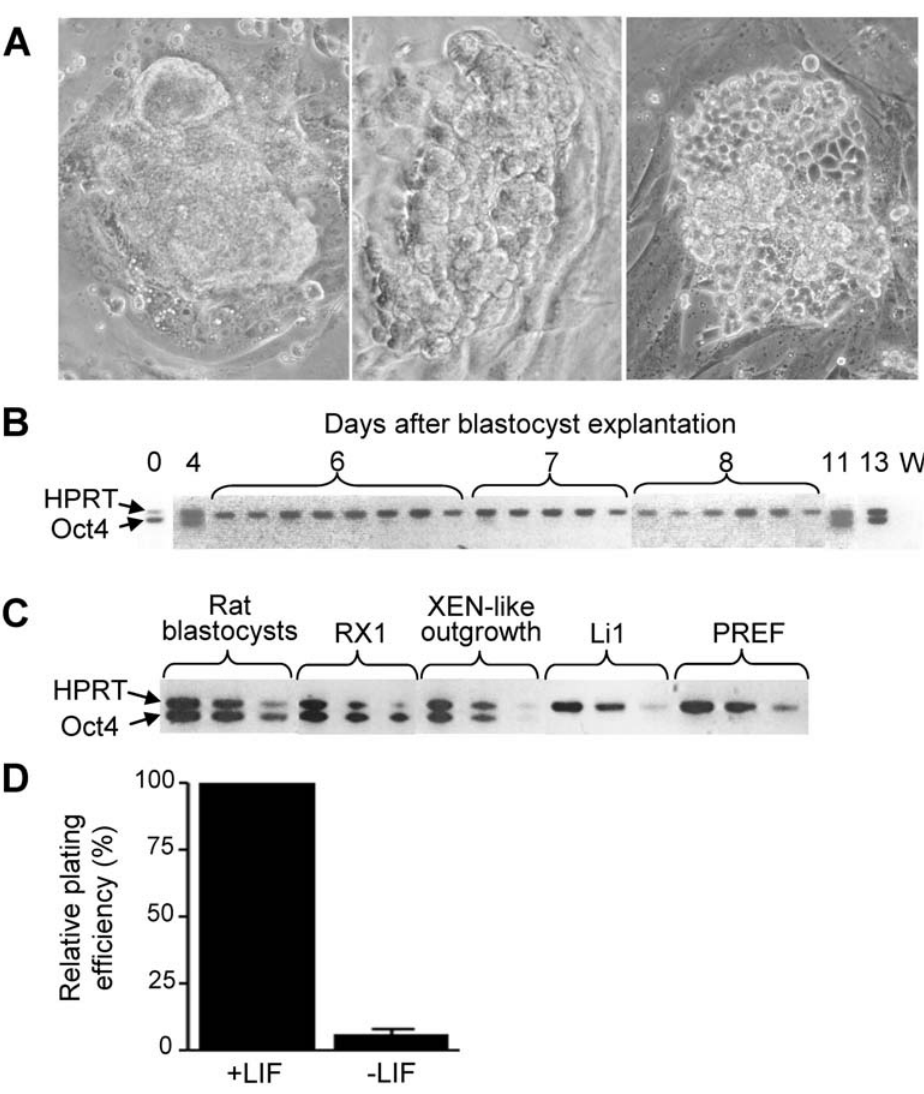
Figure 1. Properties of rat blastocyst outgrowths. ( A ) Phase contrast photographs showing stages of WKY rat blastocyst outgrowths kept on mitomycin-treated primary rat embryo fibroblasts (PREF). The outgrowths were initially smooth and compact (left), but converted to XEN morphology (right) , 10 days after blastocyst plating if not passaged, or a few days later if mechanically disaggregated into smaller clumps. Regardless of when the conversion occurred, it was fast ( , 24 hours) and went through a stage of intermediate morphology (middle). ( B ) Loss and re- expression of Oct4 mRNA in WKY rat blastocyst outgrowths. In these experiments, the outgrowths were not passaged and showed compact, smooth morphology before day 10, but XEN morphology thereafter. At the indicated days, the outgrowths were individually harvested for RT-PCR analysis, using rat-specific primers for Oct4 and hypoxanthine phosphoribosyl transferase (Hprt) cDNAs. The Oct4 and Hprt cDNAs were amplified in the same reaction; none of the primers amplified intronless products from genomic DNA (not shown). No amplification was achieved when using mouse- specific primers (not shown). Day 0=blastocyst; W, water control. ( C ) Semi-quantitative assessment of Oct4 mRNA level. Rat blastocysts (E4.5, strain WKY), XEN-P line RX1, primary XEN-like blastocyst outgrowths (strain WKY), rat embryo fibroblast line Li 1 (feeder for RX1), and PREF (feeder